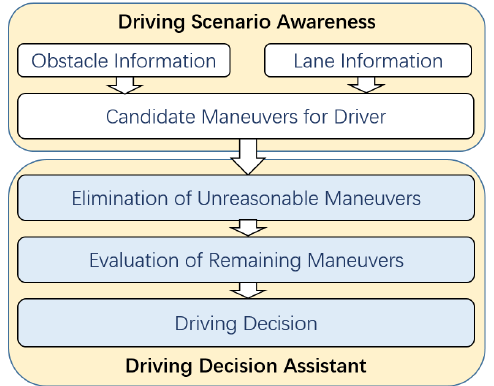
Figure 1. The framework of the proposed maneuver evaluation